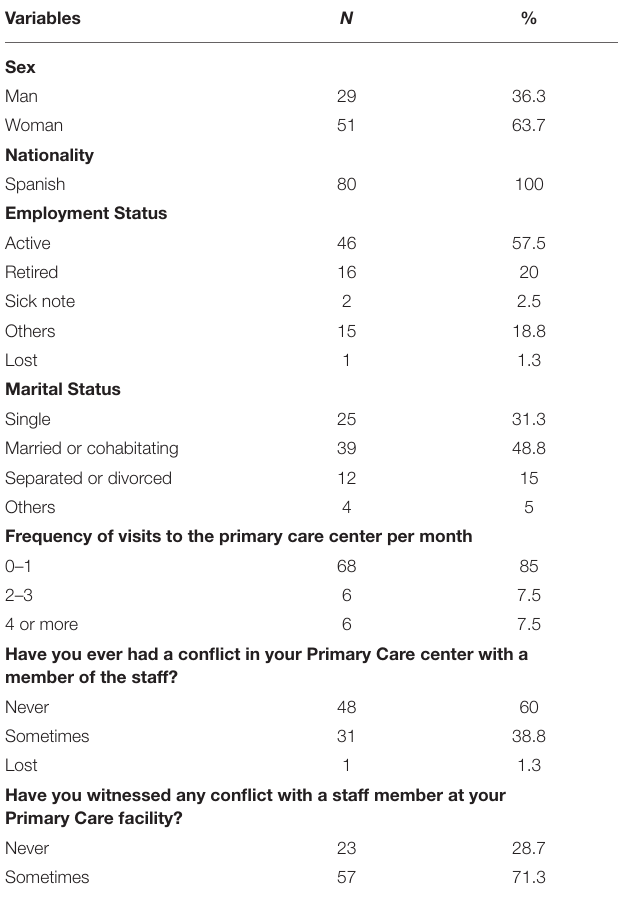
TABLE 1 | Sociodemographic and work-related